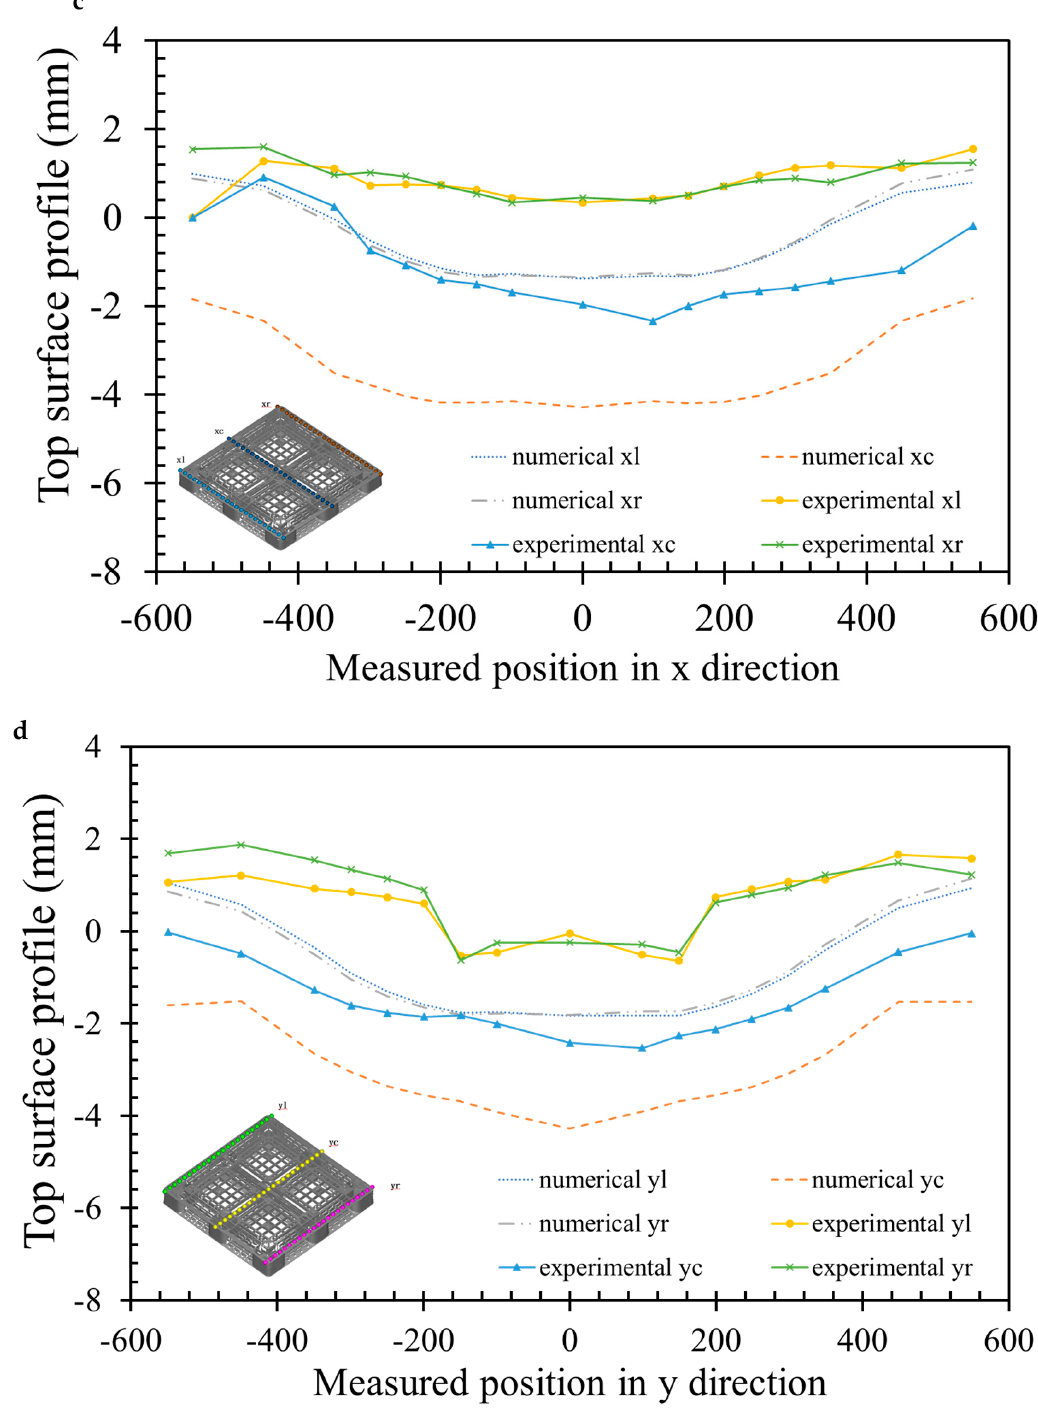
Figure 11. ( a ) Measured point for the top height of the pallet in the x-axis direction; ( b ) measured point for the top height of the pallet in the y-axis direction; ( c ) comparison between the simulated and actual top height profiles of the pallet in the x-axis direction; ( d ) comparison between the simulated and actual top height profiles of the pallet in the y-axis